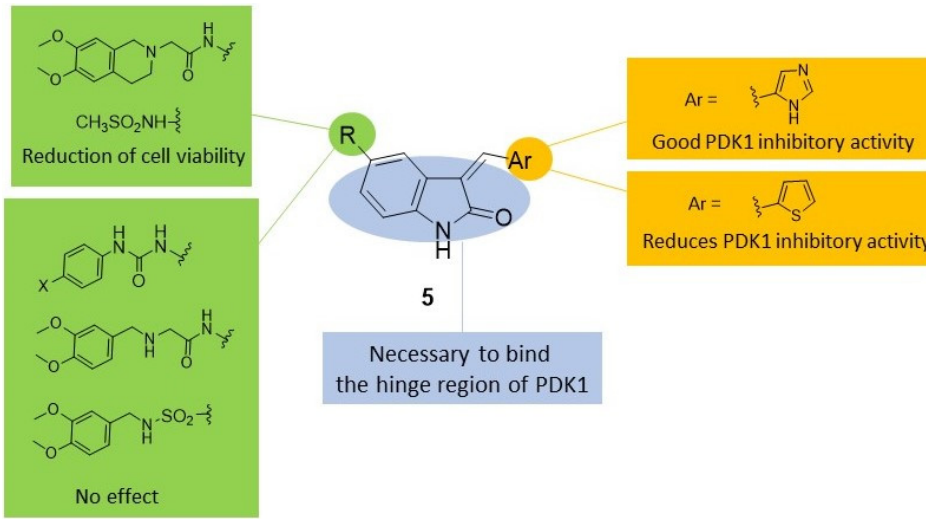
Figure 1. SAR [49] summary for PDK1 inhibitory activity and effects induced on ASPC1 cell viability by indole-based derivatives 5 .